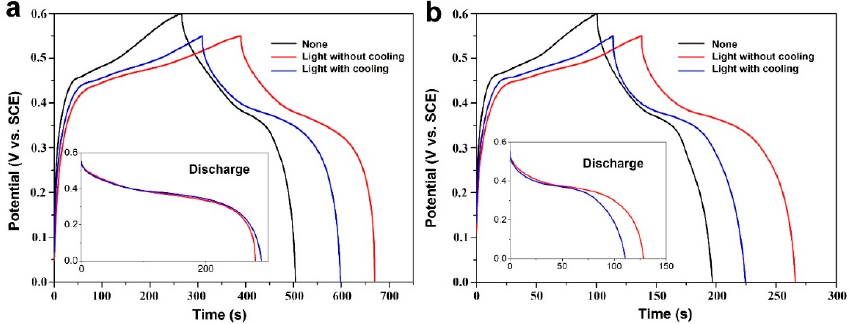
Figure 5. GCD curves collected at a current density of 5 mA cm − 2 ( a ) and 10 mA cm − 2 ( b ) of the CF@ZnCuNiO x NAs. The insets indicate the discharge curves obtained at the respective current density.